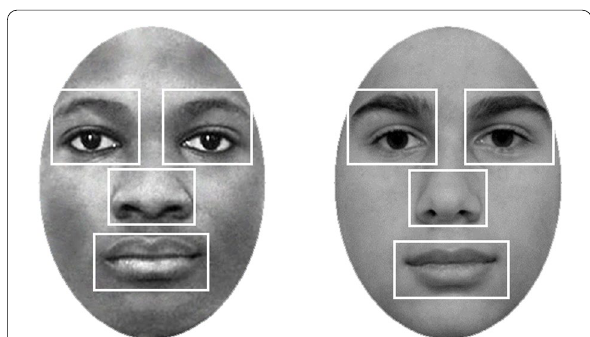
Fig. 2 Examples of Black and White female faces with defined AOIs for the eyes, nose, and mouth